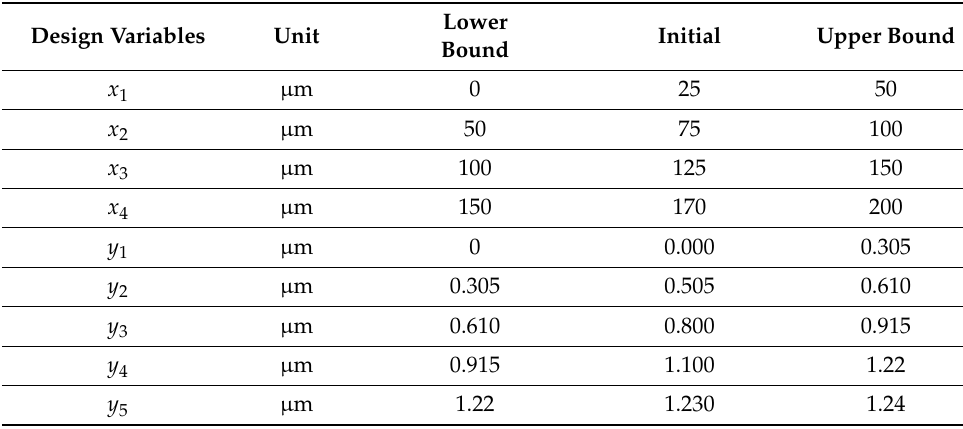
Figure 3. Design variables of the novel MEMS capacitor. Table 1. Initial, lower, and upper limit values of the design.